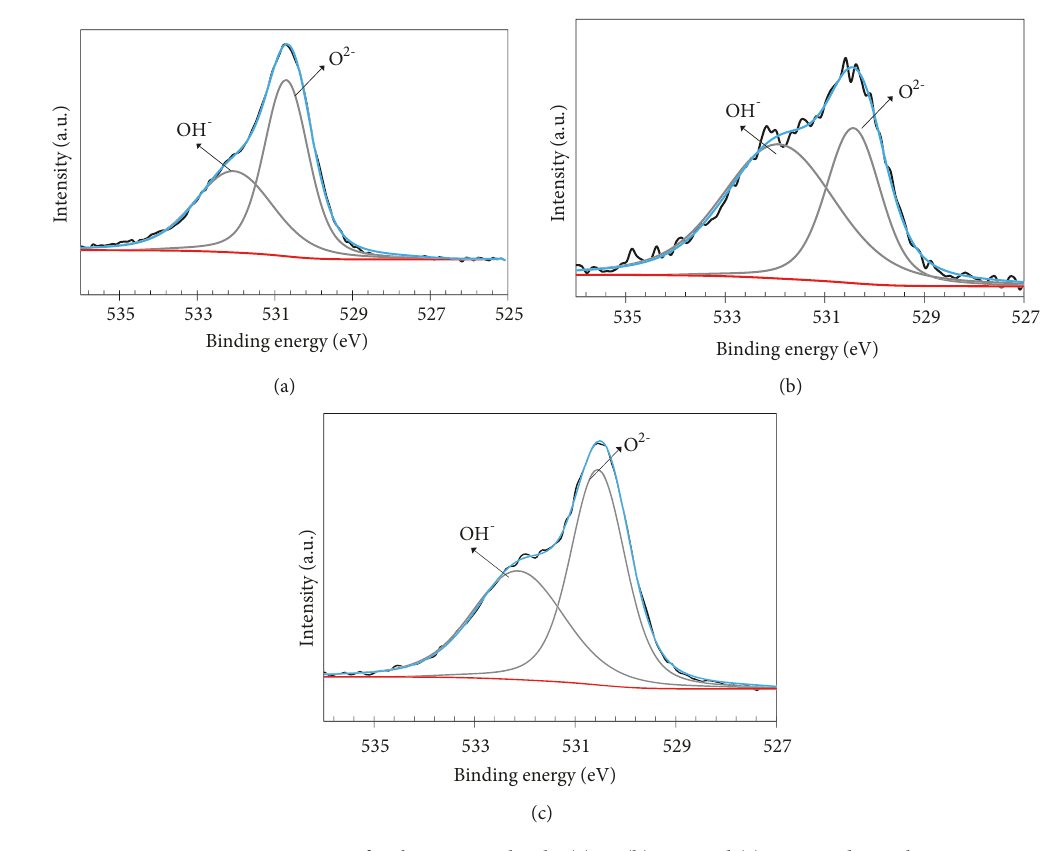
Figure 5: XPS spectra for the O1s core levels: (a) N; (b) NK; and (c) untreated samples. Table 6: XPS fitting results for the O1s core